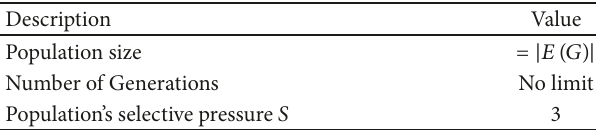
Table 1: Parameters of the Rank